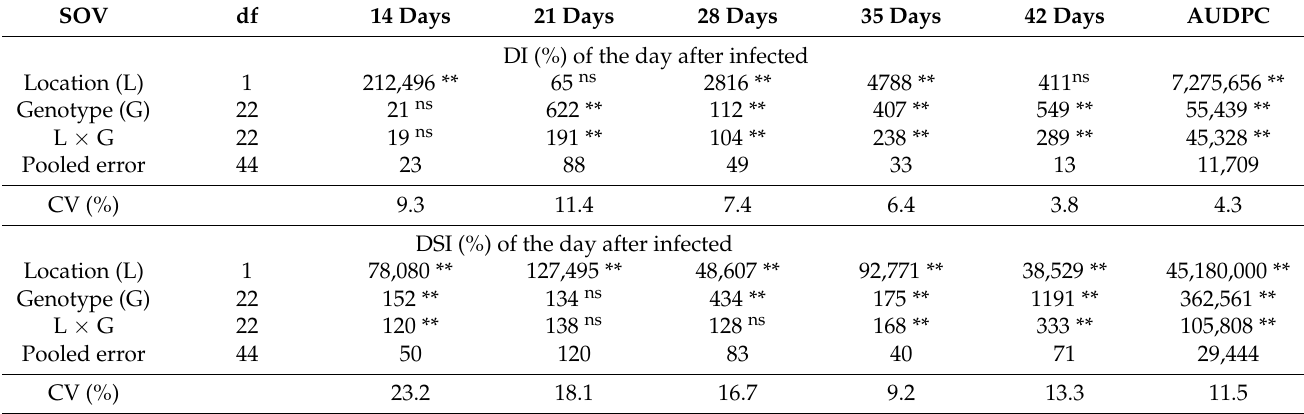
Table 4. Mean squares of combined analysis of variance for disease incidence, disease severity index, AUDPC-DI and AUDPC-DSI of 5 plant ages of 23 small-ear orange waxy corn varieties in the rainy 2020 in 2 locations.